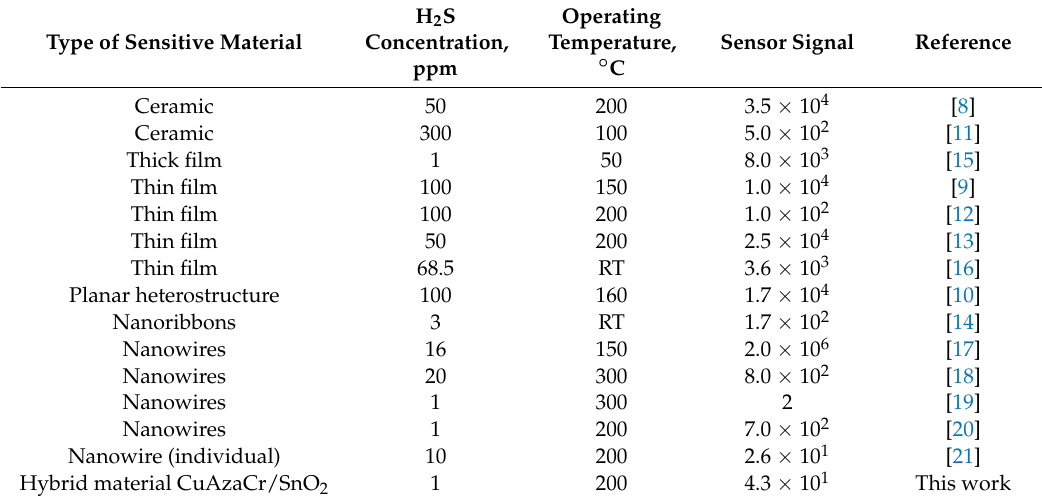
Table 3. H 2 S sensors based on p -CuO/ n -SnO 2 semiconductor